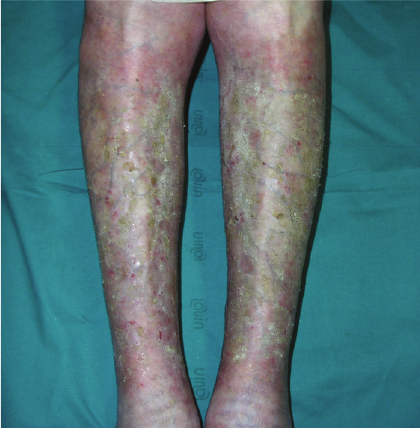
Figure 3: The complete resolution of the skin lesions after one month of